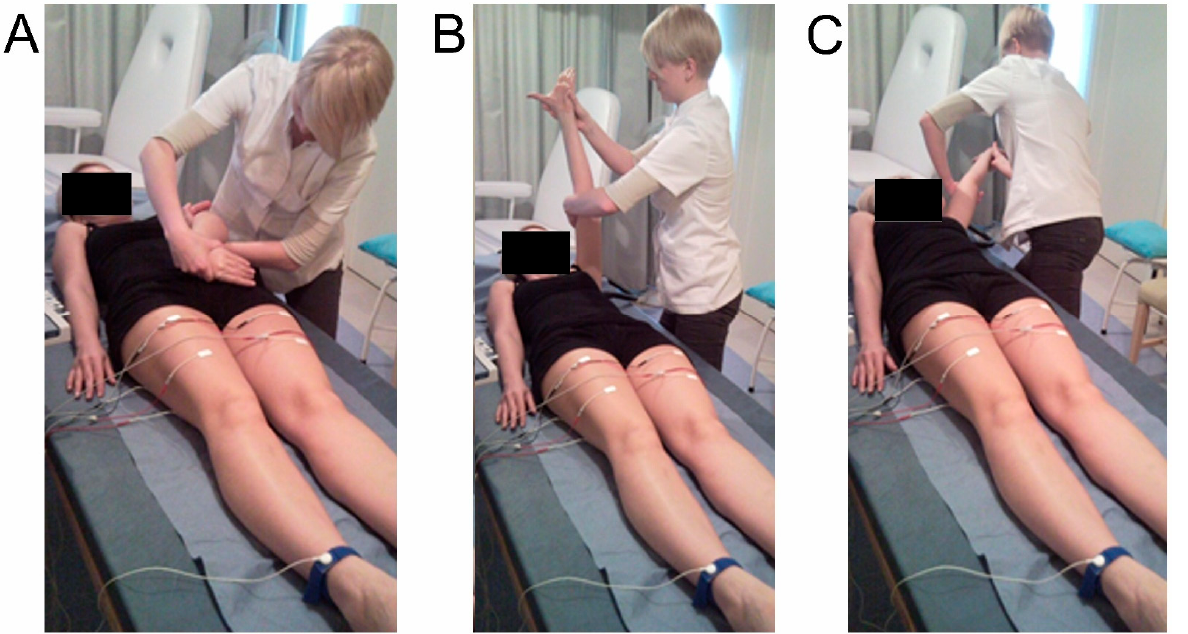
Figure 3. Examples of the PNF pattern ( A -flexion, B -abduction, and C -external rotation) applied to the upper extremity of post-stroke patients. Control electromyographical recordings from the rectus femoris muscles bilaterally detected the simultaneous muscle motor unit activity predominantly on the contralateral side, proving the properness of the applied therapy and the transmission of neu- ronal signals from the cervical to lumbosacral spinal neuromeres, probably via the fibers of the long crossed propriospinal neurons.